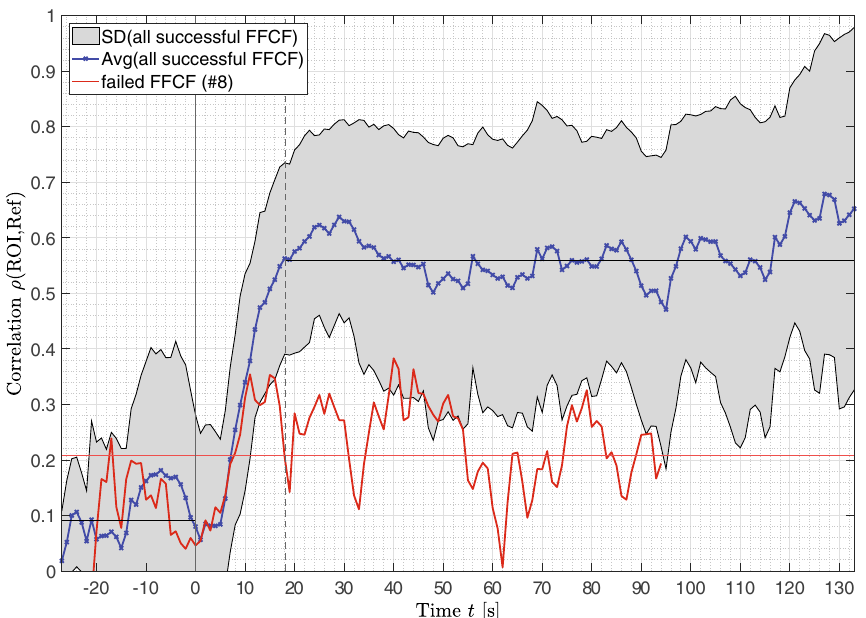
Figure 6. rPPG correlation ρ. The blue curve represents the average of all successful transplanted FFCFs and the gray area includes the SD. In comparison, the red curve shows the correlation of failed flap (#8). The time point t = 0 s marks the documented reperfusion. The reperfusion is detectable in the data after t = 18.08 s. The horizontal black line until t = 0 s marks the average correlation of ischemia with 0.09, while the average correlation after reperfusion is 0.56. The horizontal red line marks the average correlation of the failed flap with ρ = 0.208 ± 0.090